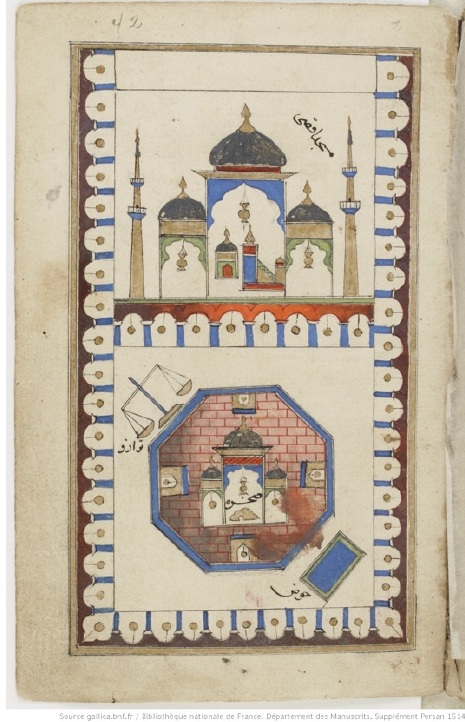
Figure 4. Jerusalem. Mu ḥ y ī al-D ī n L ā r ī , Fut ū ḥ al- Ḥ aramayn , 1577 A.D., Bibliothèque nationale de France, Paris, Suppl. Pers. 1514, folio 42r. © Bibliothèque nationale de France. 2022.